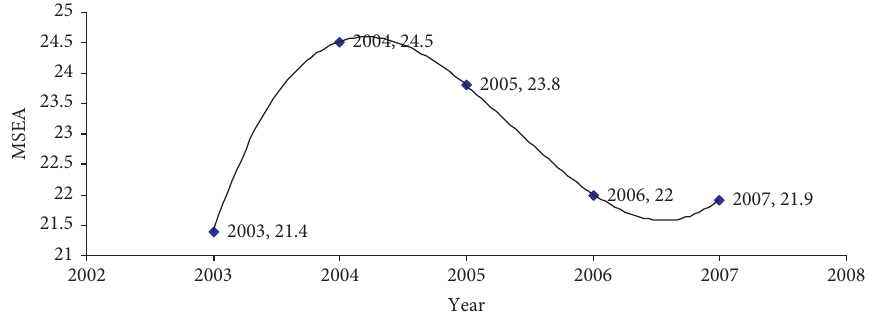
Figure 5: Best-fitting regression curve of MSEA in December, Queensland, Australia.